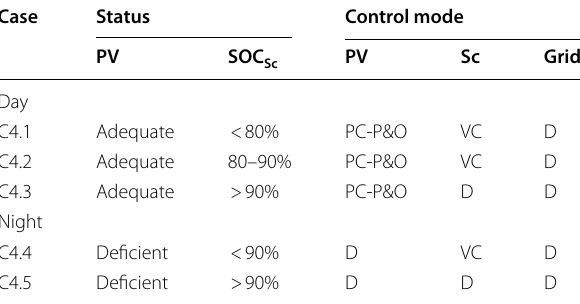
Table 4 Port state and control mode of deceleration